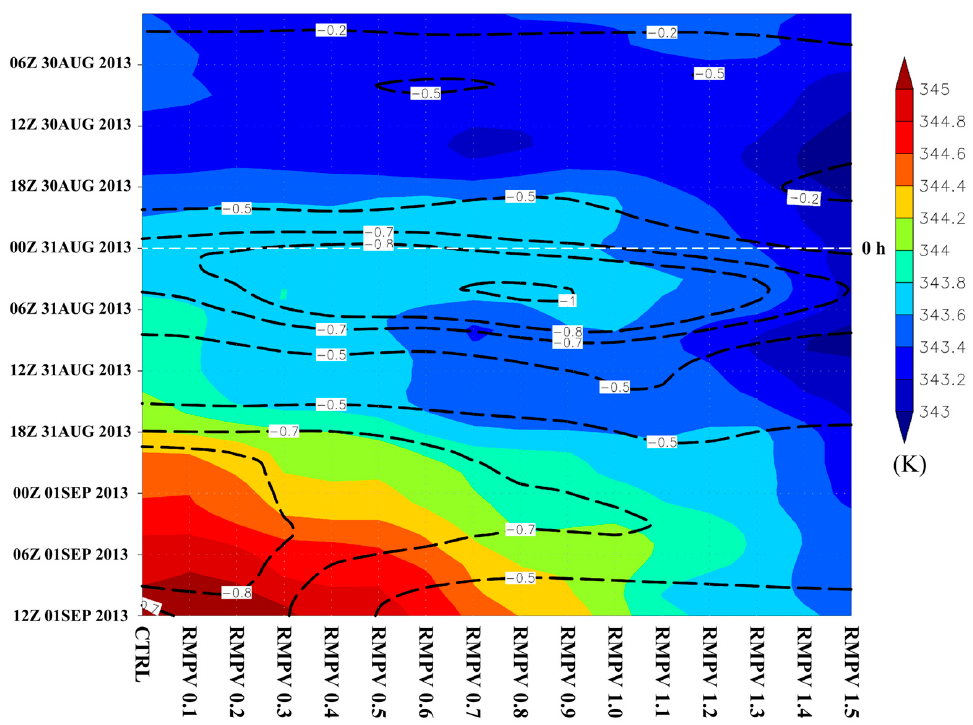
Figure 11. Time series of high-level potential temperature (averaged from 400 hPa to 300 hPa) (shading; K) and mid-level vertical velocity (averaged from 600 hPa to 400 hPa) (contours; Pa s − 1 ) derived from each experiment averaged over a 2°-radius area centered at 700 hPa vortex center in every 1 h. Time ranges from 0000 UTC 30 August ( − 24 h) to 1200 UTC 1 September (+36 h).